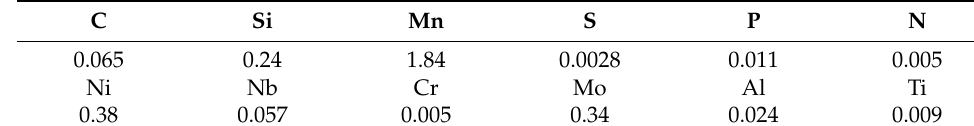
Table 2. Chemical composition of X80 base metal steel (wt%).